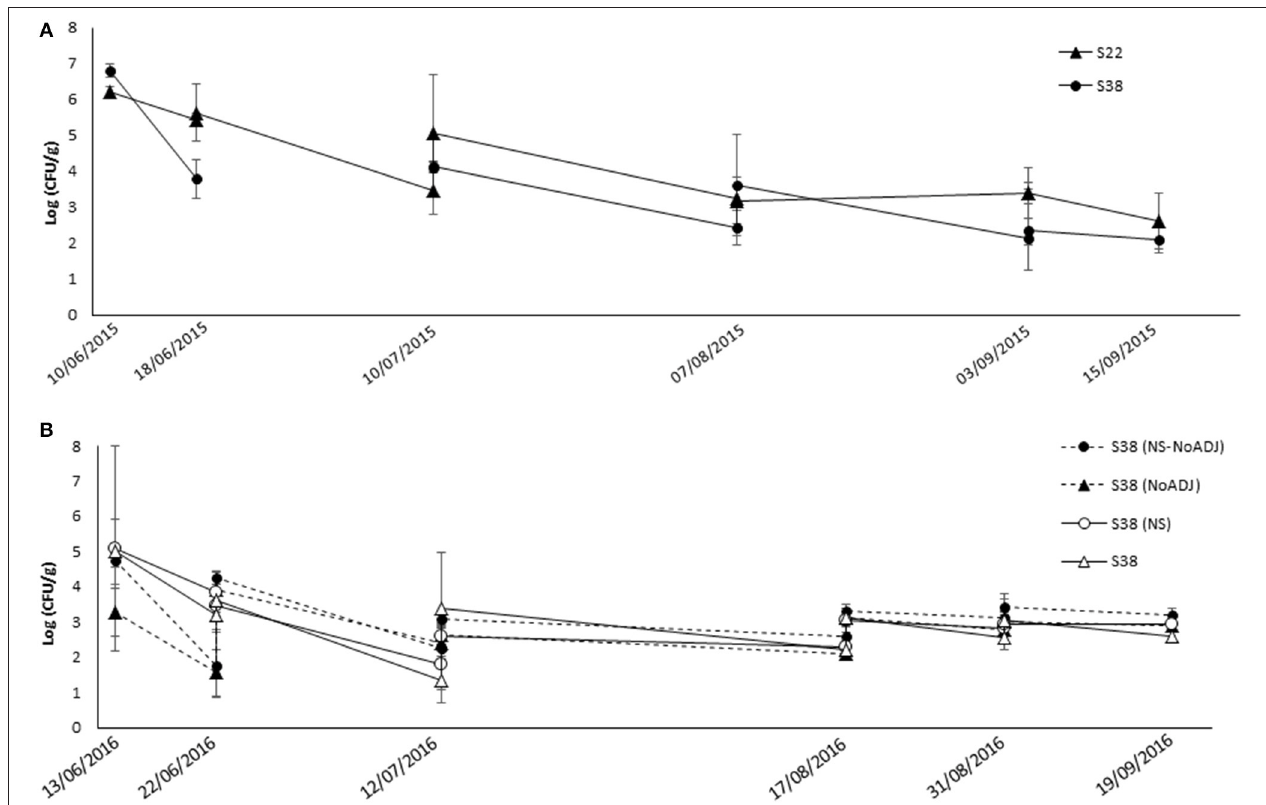
FIGURE 1 | Population dynamics of experimental bacterial strains following spray applications against Botrytis bunch rot in the “CHS” vineyard. During the 2015 (A) and 2016 (B) growing seasons, grapevines cv. Semillon were sprayed with bacterial suspensions of S38 (black triangles): Bacillus ginsengihumi S38 strain at 5 x 10 7 CFU ml − 1 + Sticman ® adjuvant at 0.14% (v/v); or S22 (black circles): Enterobacter cowanii S22 strain at 5 x 10 7 CFU ml − 1 + Sticman ® adjuvant at 0.14% (v/v). (NS) : Non Supernatant in the bacterial formulation; NoADJ : No Sticman ® adjuvant in the treatment mixture. Applications were carried out at five key phenological stages in the season: Flowering (10% cap fall; BBCH = 61); Flowering (100% cap fall; BBCH = 69); Pre-bunch closure (BBCH = 77); 10% Veraison (BBCH = 81); and 21 days before harvest (BBCH = 85). Samples of flowers and berries were collected after and just before each spray application, and at harvest date. Error bars represent Standard Deviation of the